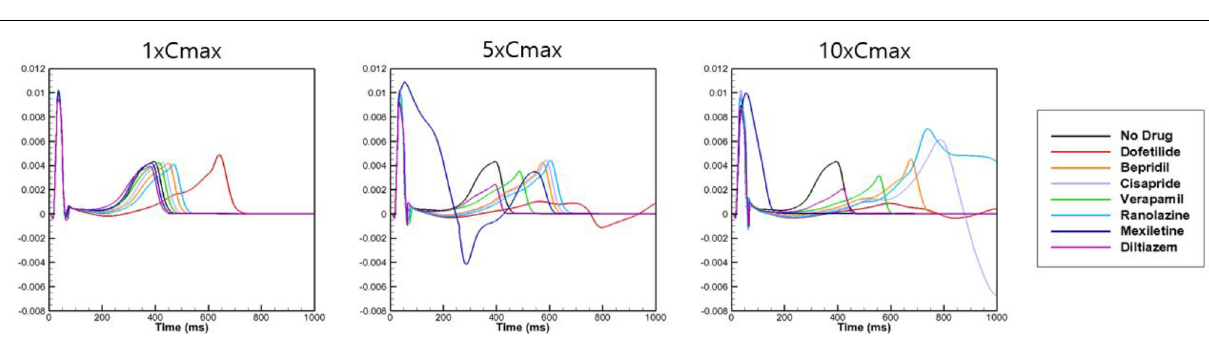
FIGURE 3 | Action potentials with different cell models. Action potential curves are shown for 7 drugs with 4 different cell models at 1 × Cmax. Action potentials of endocardial, M, and epicardial cells are shown.